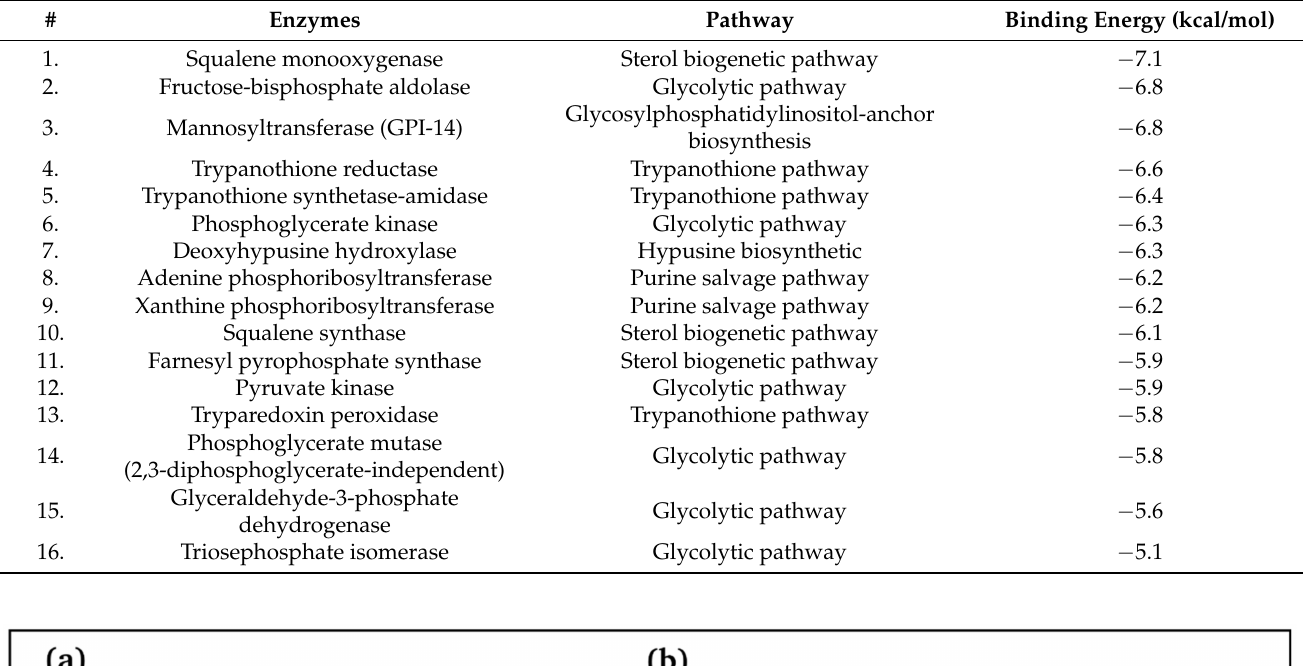
Table 3. Protein-ligand predicted binding energy obtained from molecular docking studies.